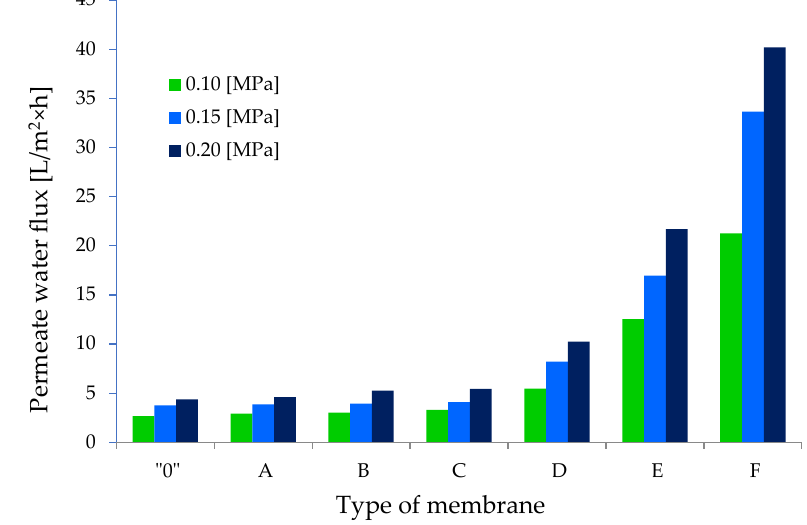
Figure19. PurewaterpermeabilityforthepurecellulosemembraneandGO / Figure 19. Pure water permeability for the pure cellulose membrane and GO/CEL composite membranes.